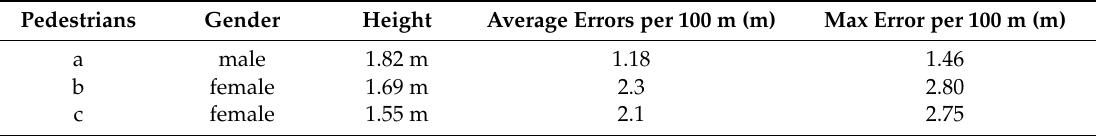
Table 3. Errors with PDR in